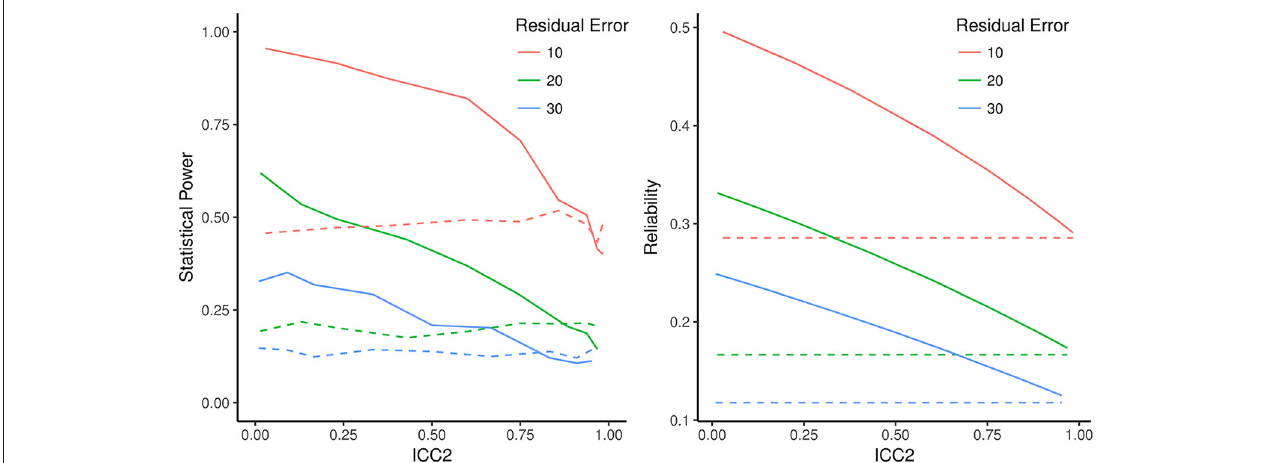
FIGURE 3 | Statistical power for specific variance test and Wald test, and effective curve reliability (ECR) and Growth Rate Reliability (GRR), as an effect of varying intercept variance scaled as the intra-class correlation coefficient (ICC 2 ). Left : Lines are Monte Carlo estimates of statistical power of the specific variance test (solid) and Wald test (dashed) with each line representing a model with different residual error variance. Right : Corresponding ECR (solid lines) and GRR (dashed lines). GRR is constant for all intercept variance values (scaled as ICC 2 ) whereas ECR traces the shape of change in statistical power as seen in the left panel. GRR and ECR converge to the same value as ICC 2 approaches